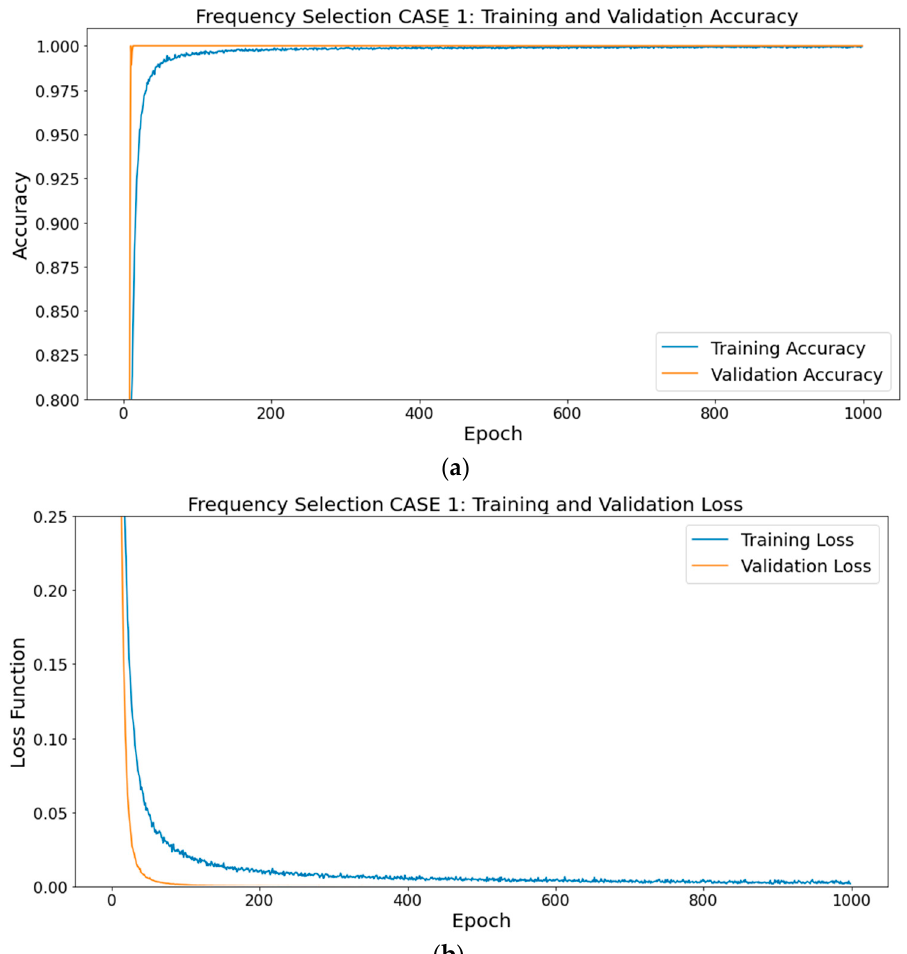
Figure 8. Accuracy and loss function within 1000 training steps: ( a ) the train accuracy and the validation accuracy; ( b ) the train loss function and the validation loss function.